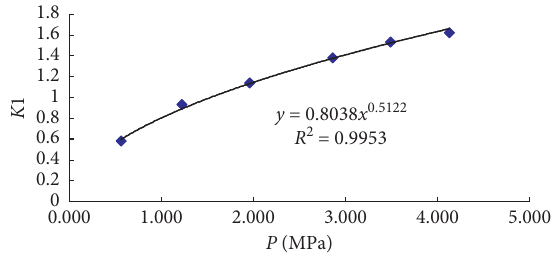
Figure 4: K – P relationship model in the transportation roadway 1 in the 121901 working face.